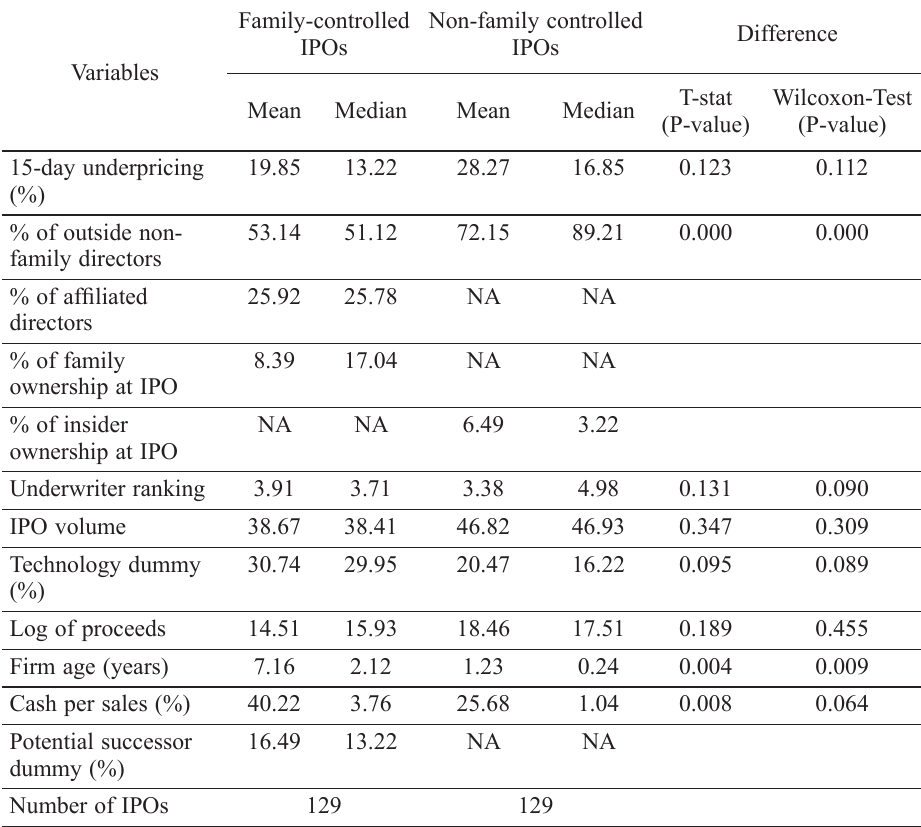
Table 1. Descriptive statistics of IPO